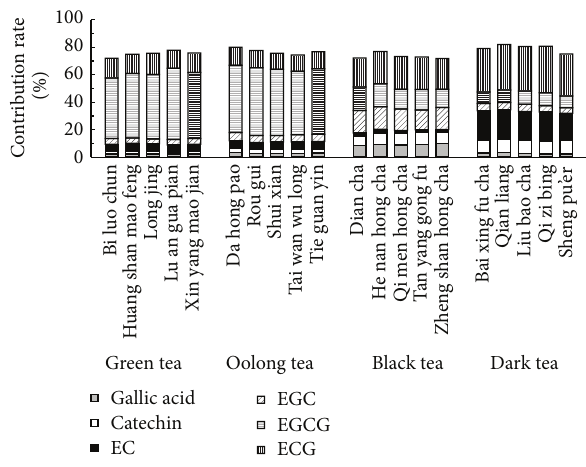
Figure 10: Contributions of gallic acid and catechins in tea to DPPH-scavenging